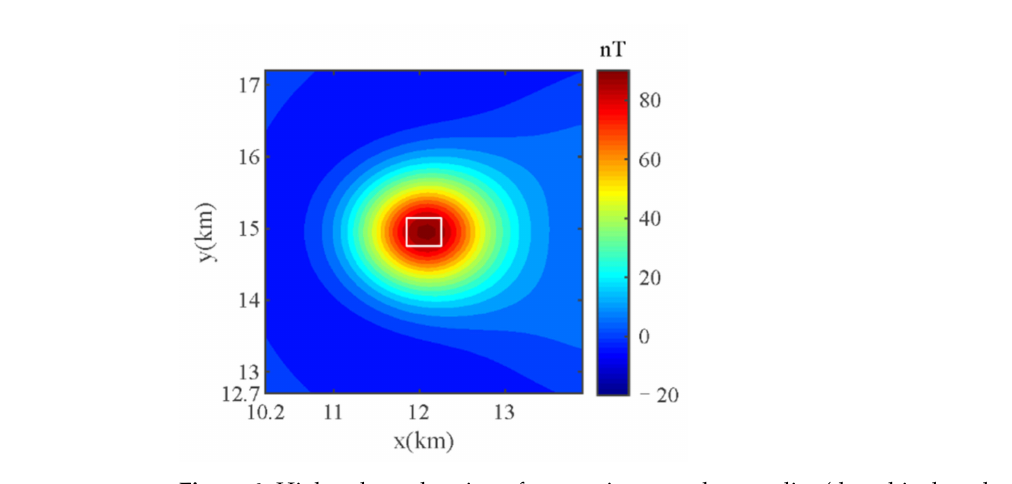
Figure 6. High-value subregion of magnetite-caused anomalies (the white box denotes the actual scope of the magnetite